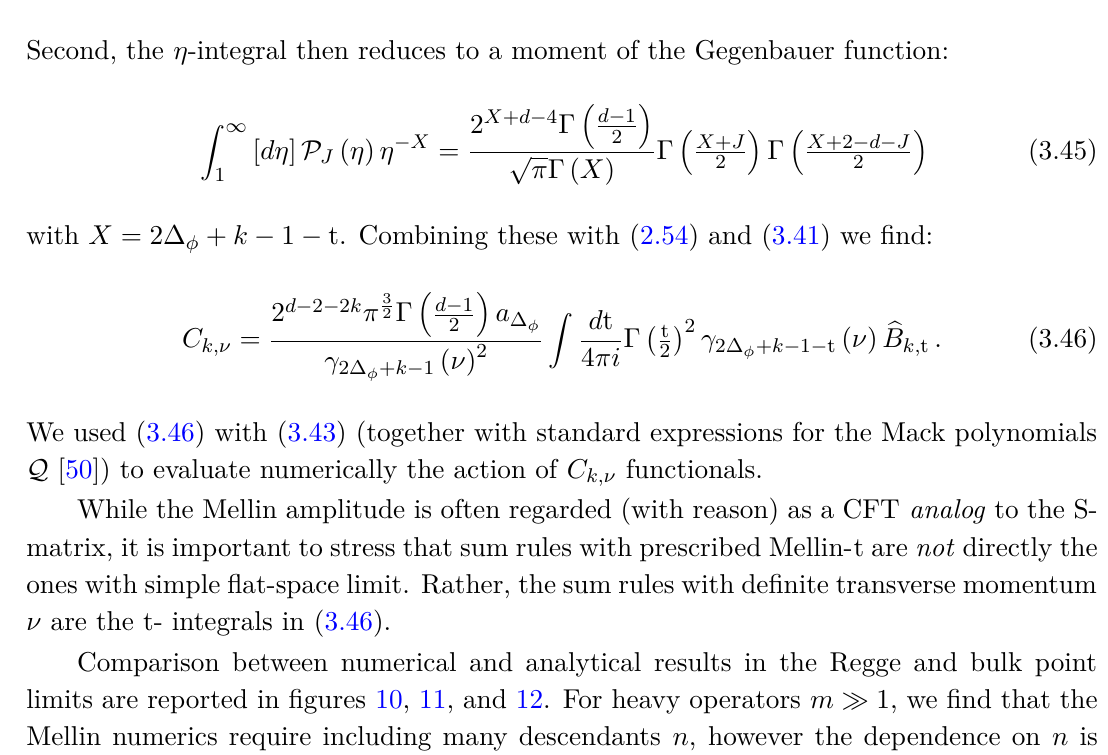
Figure 11. Residual errors in the Regge limit, for the functional in figure 10 after subtracting various partial sums of the 1 /m 2 series from high-precision Mellin-space numerics. Including the 1 /m 8 term yields 10 − 9 relative accuracy at m = 70 , nontrivially validating both the analytic and numerical formulas. Although the coefficient of 1 /m 8 is anomalously small in this particular example, the residual is well fitted by a 1 /m 10 power